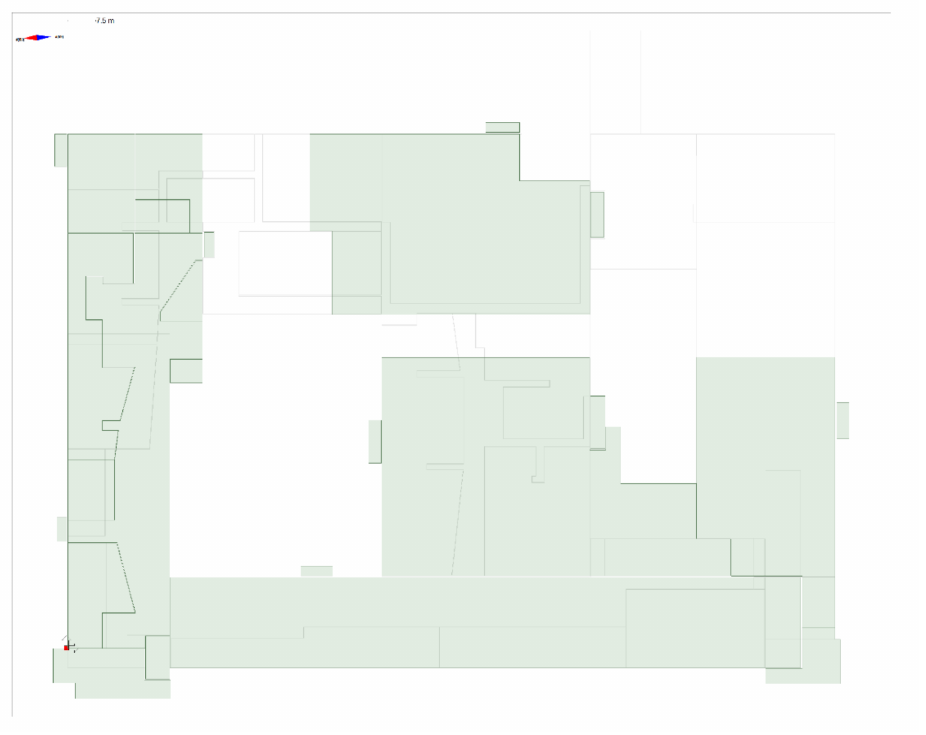
Figure A1. First floor ( z = 0.0